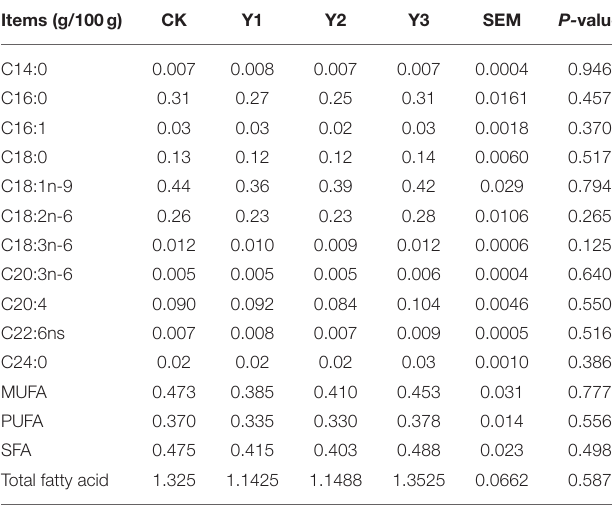
TABLE 5 | Effects of dietary AOE on meat fatty acid composition in breast muscle of ducks.